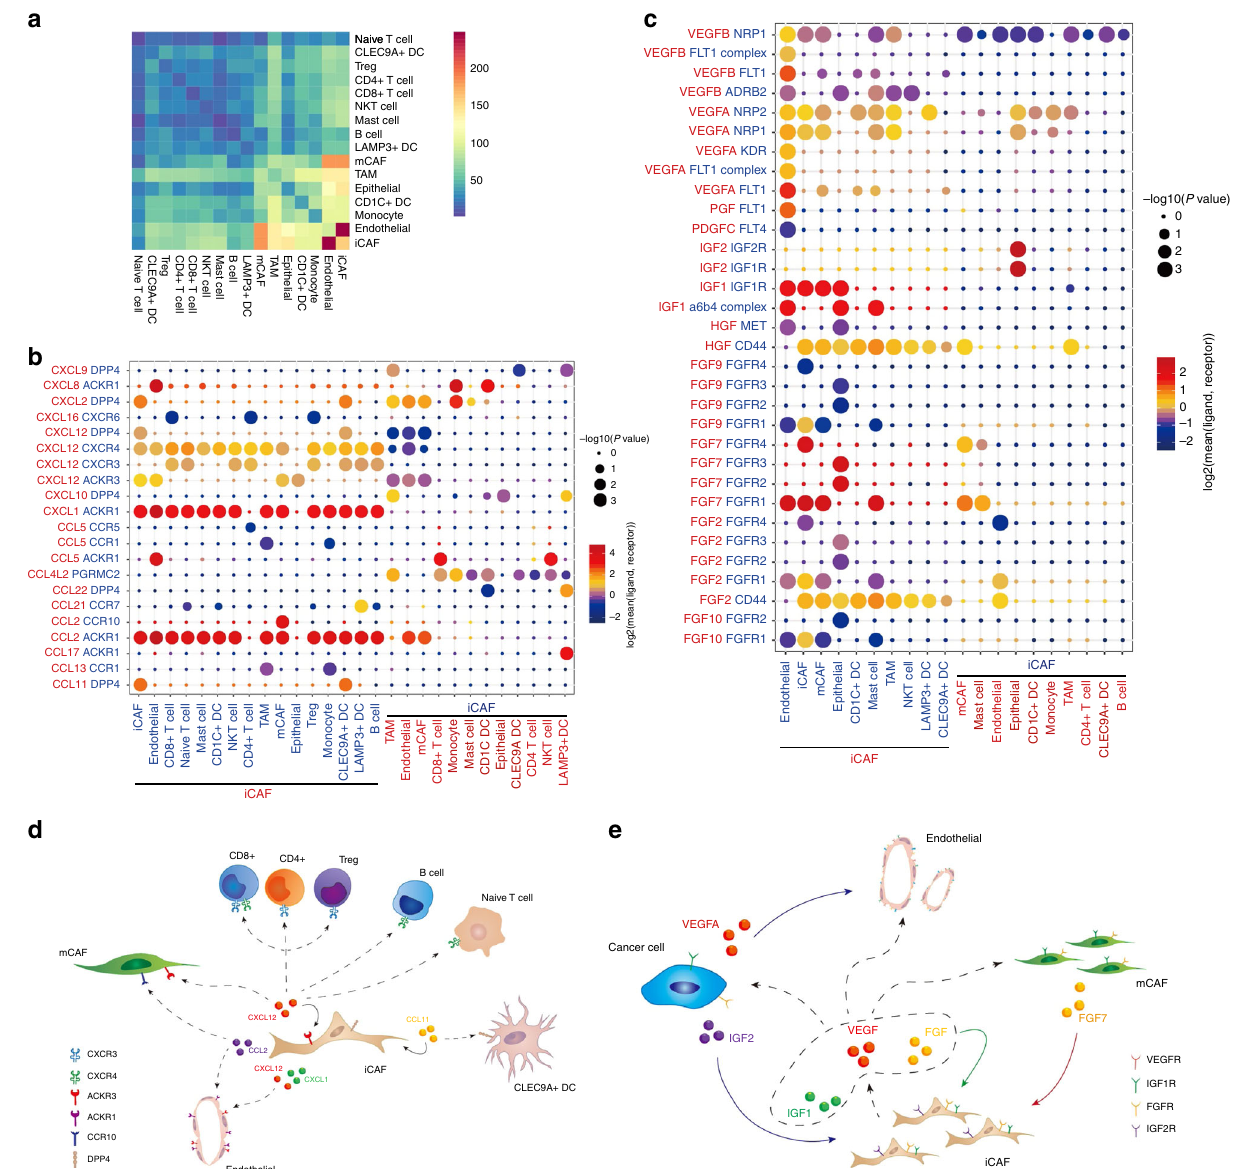
Fig. 6 Cell – cell communication network in BC TME. a Heatmap show number of potential ligand-receptor pairs between cell groups predicted by CellphoneDB 2. b , c Bubble plots show ligand-receptor pairs of cytokines b and growth factors c between iCAFs and other cell groups. d , e Predicted regulatory network centered on